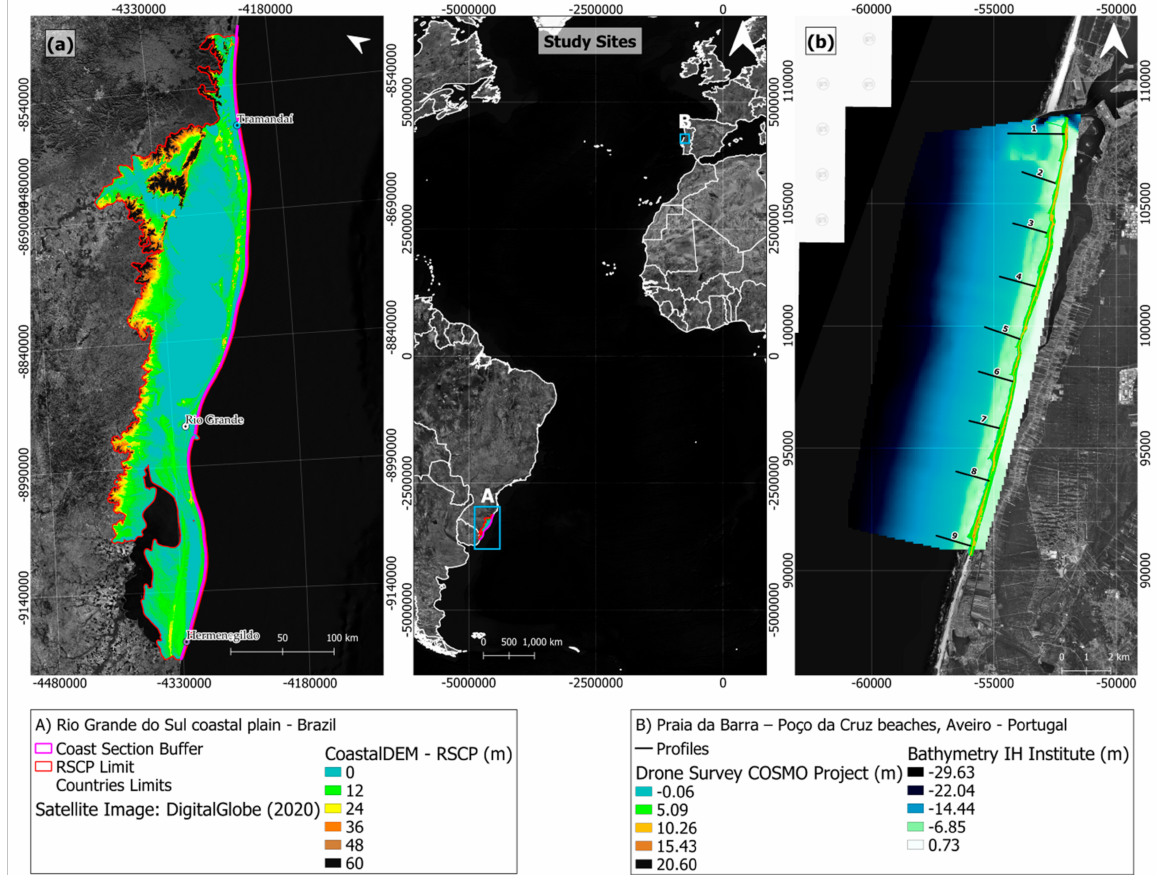
Figure 1. Study sites: ( a ) Rio Grande do Sul coastal plain, Brazil (coordinate system: SIRGAS 2000—UTM22). ( b ) South Aveiro lagoon entrance (Barra—Poço da Cruz coastal strecht), Portugal (coordinate system: ETRS 89 TM